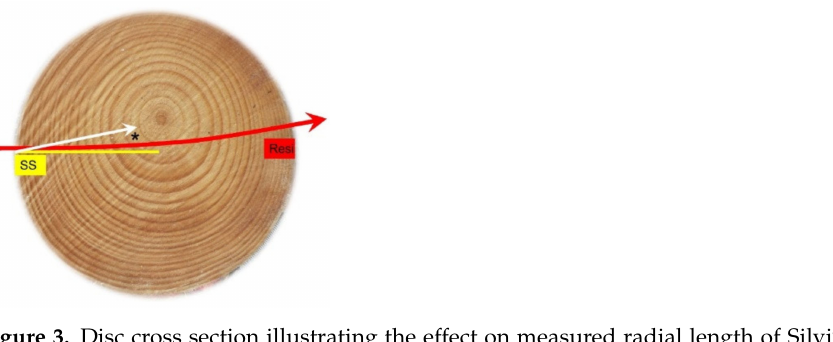
Figure 3. Disc cross section illustrating the effect on measured radial length of SilviScan profiles (yellow line) and Resi traces (red line). The white arrow and asterisk indicate the direct bark-to-pith trajectory obtained from the SilviScan analyses (see text for